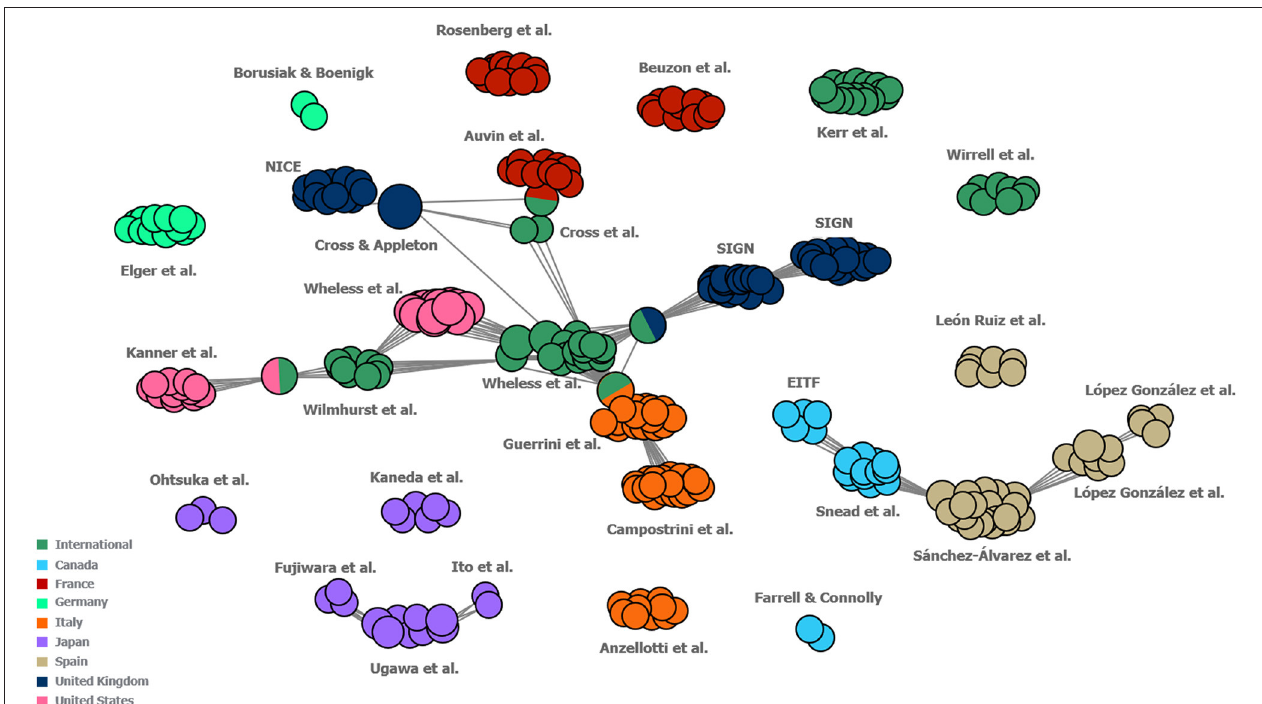
FIGURE 6 | Map of collaboration between the author groups of included guidelines. Each individual circle represents one author of a guideline. Each “cluster” represents the group of authors that developed one guideline. Each cluster is labelled with the names of its respective first author(s). Guidelines which share one or more authors between them are connected by grey lines, with single circles between guideline clusters representing the individuals who authored both guidelines in question. Guidelines were classified as “International” if they were developed either for multiple countries or did not specify to which countries they pertained. Guidelines for which author names were not reported have not been included in this figure. EITF, Epilepsy Implementation Task Force; NICE, National Institute for Health and Clinical Excellence; SIGN, Scottish Intercollegiate Guidelines Network.